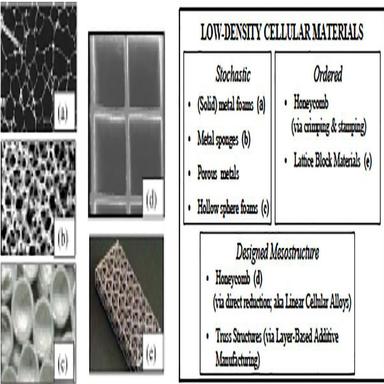
Classification of Low density cellular material mesostructure.